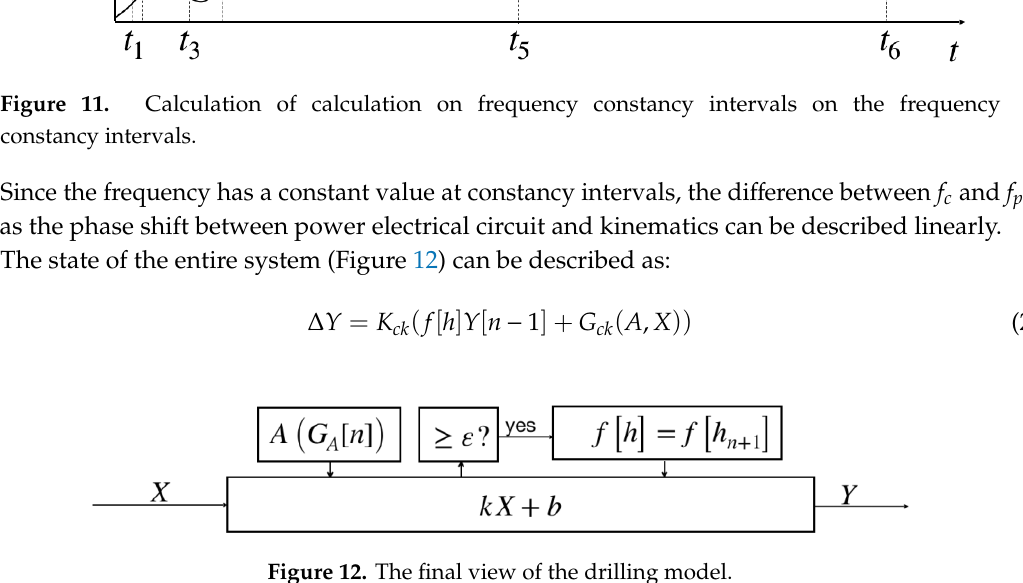
Figure 12. The final view of the drilling model.